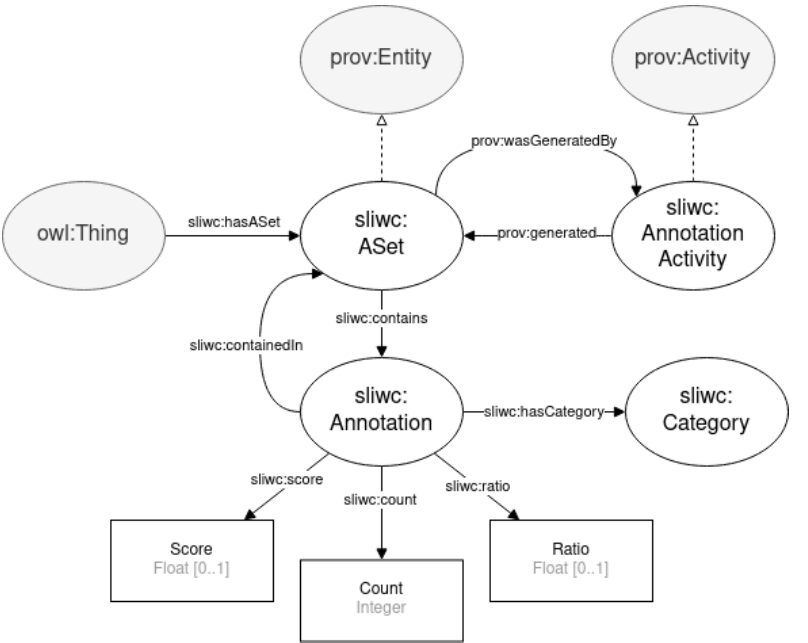
Figure 1. Main concepts related to annotation in the SLIWC